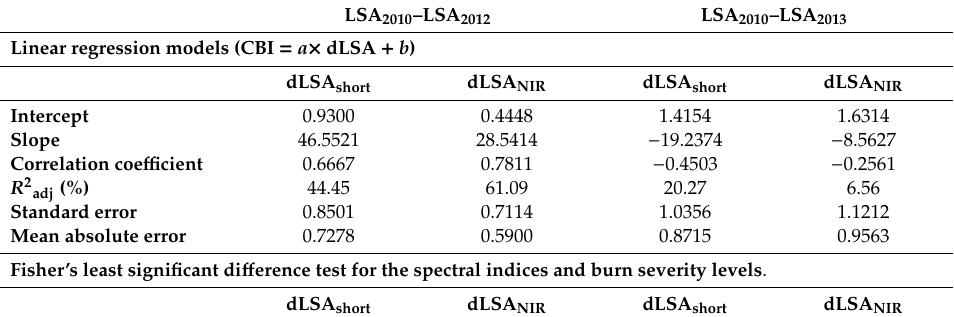
Figure 4. The di ff erence between the pre- and immediately post-fire LSA short ( left ) and the di ff erence between the pre- and immediately post-fire LSA NIR ( right ). Table 3. The linear regression models between the ground measured CBI and the pre- and post-fire di ff erenced LSA images (shortwave and NIR), and Fisher’s least significant di ff erence test for them and for the burn severity